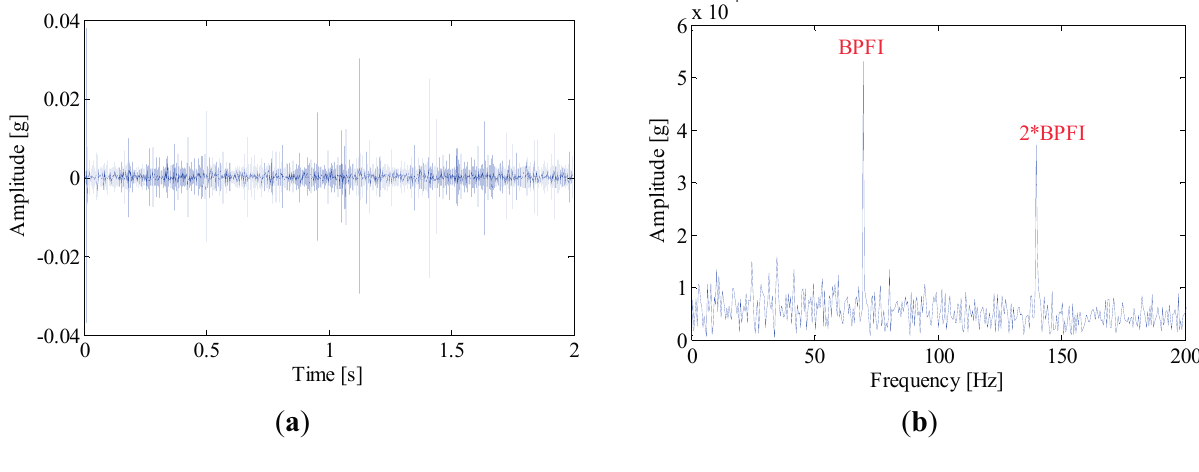
Figure 28. FSM of locomotive bearing